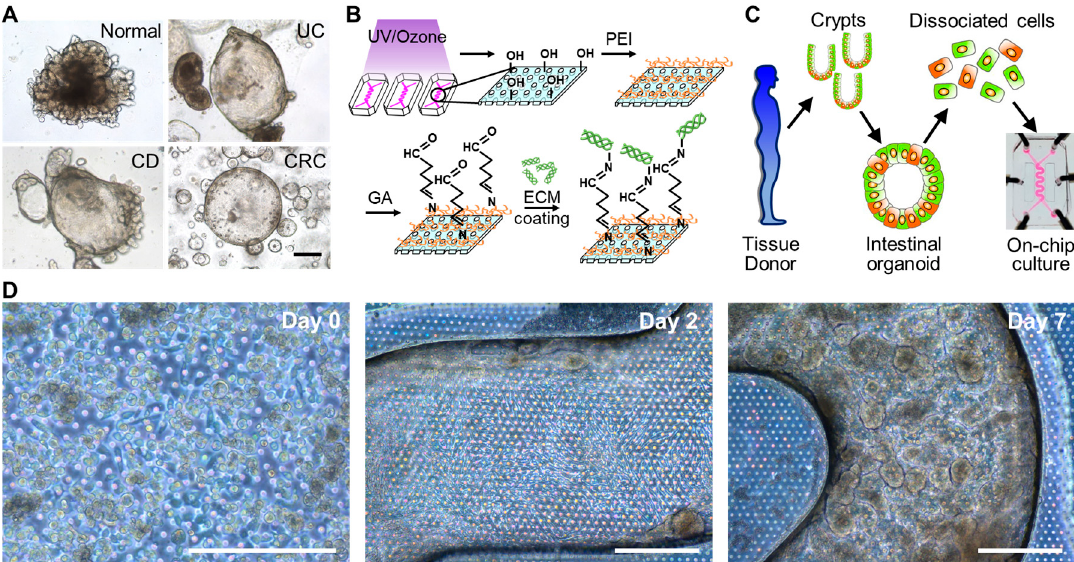
Figure 3. The microfluidic culture of the patient-derived organoid epithelium in a PMI Chip. ( A ) The phase contrast micrographs of human intestinal organoids derived from a normal donor or the patients diagnosed with UC, CD, and CRC. ( B ) The experimental procedure for the activation of a microfluidic channel and a subsequent ECM coating in a PMI Chip. ( C ) The procedure of the formation of biopsy-derived intestinal organoids and its use for a microfluidic culture in a PMI Chip. ( D ) The phase contrast images that show the 3D regeneration of patient-derived intestinal organoid epithelium under non-linear luminal flow and multiaxial stretching motions. Normal organoid cells were cultured in a PMI Chip for 7 days under flow (50 µL/h) and stretching motions (5%, 0.15 Hz). Bars, 200 µm.